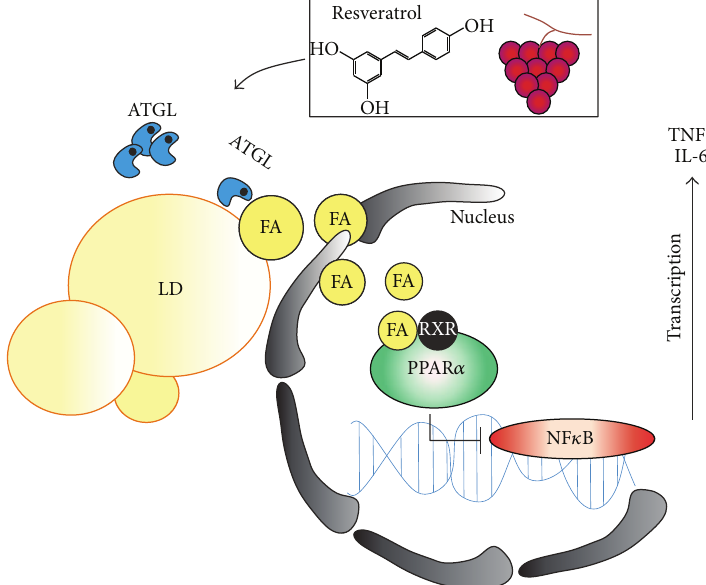
Figure 4: Schematic representation of the ATGL-dependent anti-inflammatory action of resveratrol. Aged adipocytes are characterized by impaired ATGL/FA/PPAR 𝛼 signalling pathways and by the production of proinflammatory cytokines (TNF 𝛼 and IL-6). Resveratrol induces ATGL upregulation, activating FA-mediated PPAR 𝛼 anti-inflammatory effect. ATGL: adipose triglyceride lipase; FA: fatty acid; IL-6: interleukin 6; LD: lipid droplet; NF 𝜅 B: uclear factor kappa beta; PPAR 𝛼 : peroxisome proliferator activated receptor 𝛼